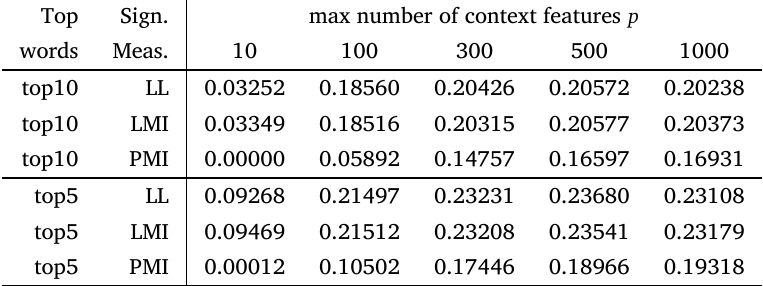
Table 4: Wordnet Path Similarity for 1000 infrequent nouns for DTs computed on 10 million sentences Top Sign. max number of context features